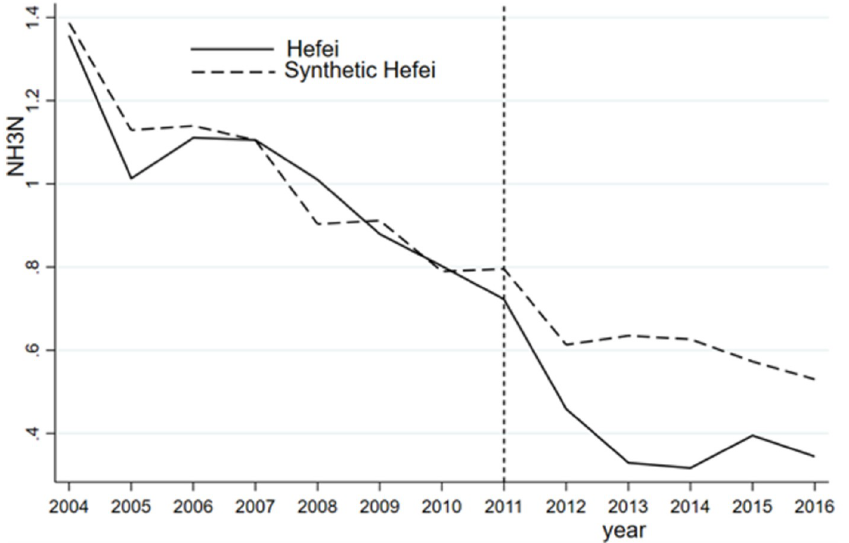
Fig 5. NH 3 N of Hefei and synthetic Hefei (excluding Beijing, Shanghai, and